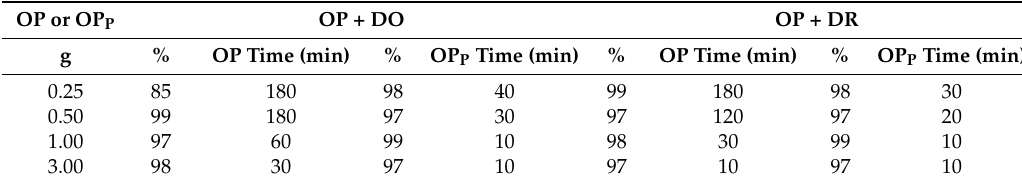
Table 1. Effect of Olive pomace (OP) and sieved Olive Pomace (OP P ) amount (in grams for 40 mL